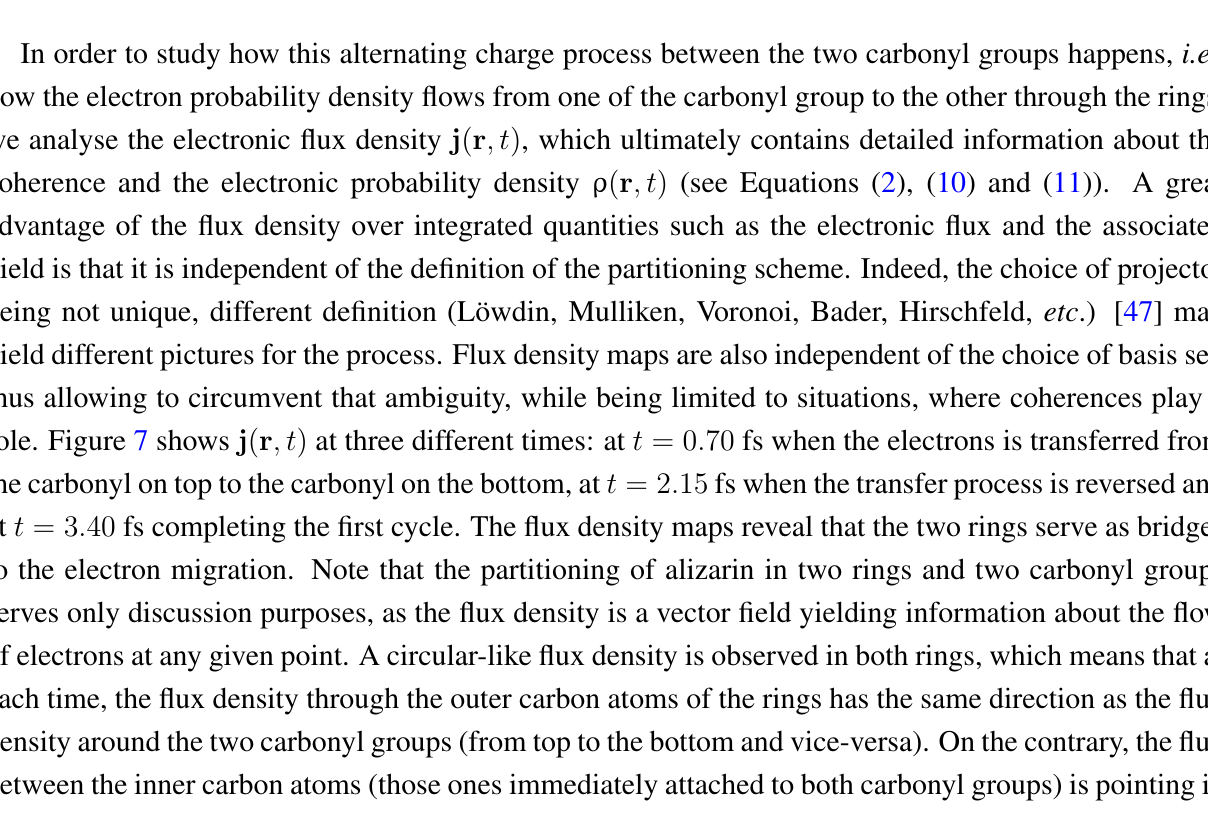
Figure 6. Evolution of the electron density on the alizarin moiety from the coherent wave packet dynamics. The contour values for the dark and light grey contours are chosen as − 3 − 3 6 . 75 · 10 − 4 Å and 6 . 75 · 10 − 5 Å ,